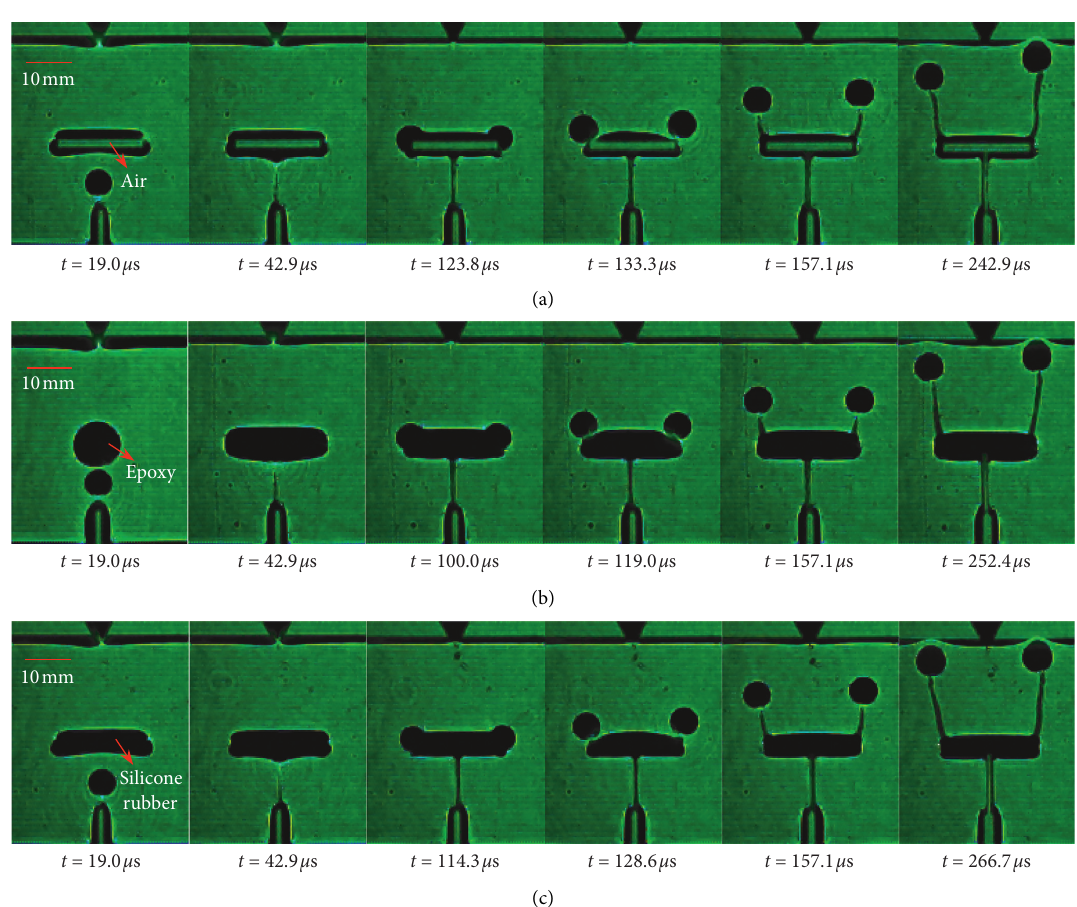
Figure 6: Caustics photos of the interaction between the running crack and rectangular defect. (a) Specimen T Specimen T s